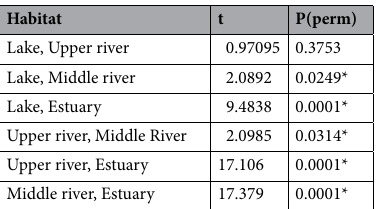
Table 2. Post hoc pairwise comparisons (PERMANOVA) of multi-elemental signatures of Galaxias maculatus otolith edges among habitats. Asterisks indicate significant differences, P <